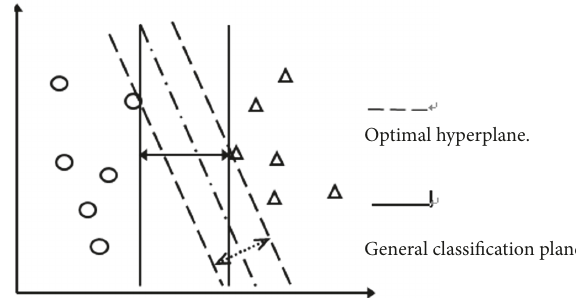
Figure 4: The comparison of optimal classification hyperplane and common classification